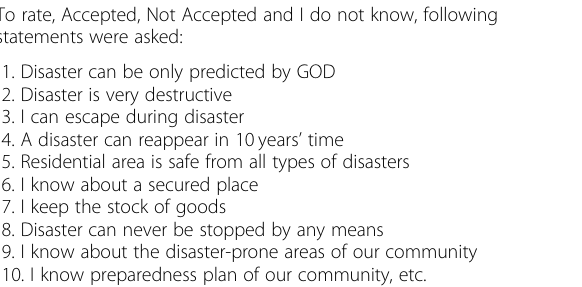
Table 3 Disaster awareness, adaptations and risk perceptions items